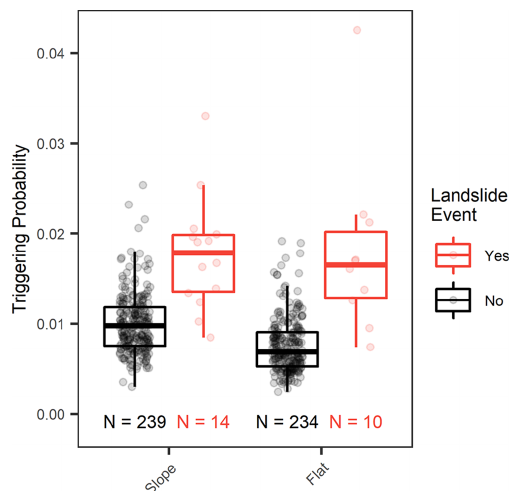
Figure 14. Boxplots showing the triggering probability distribution of infiltration events without (black) and with landslides (red) ap- plied to the sloped and flat site separately, based on simulated soil moisture (number of upslope models defining lateral flow at sloped site was five). The number of infiltration events is indicated at the